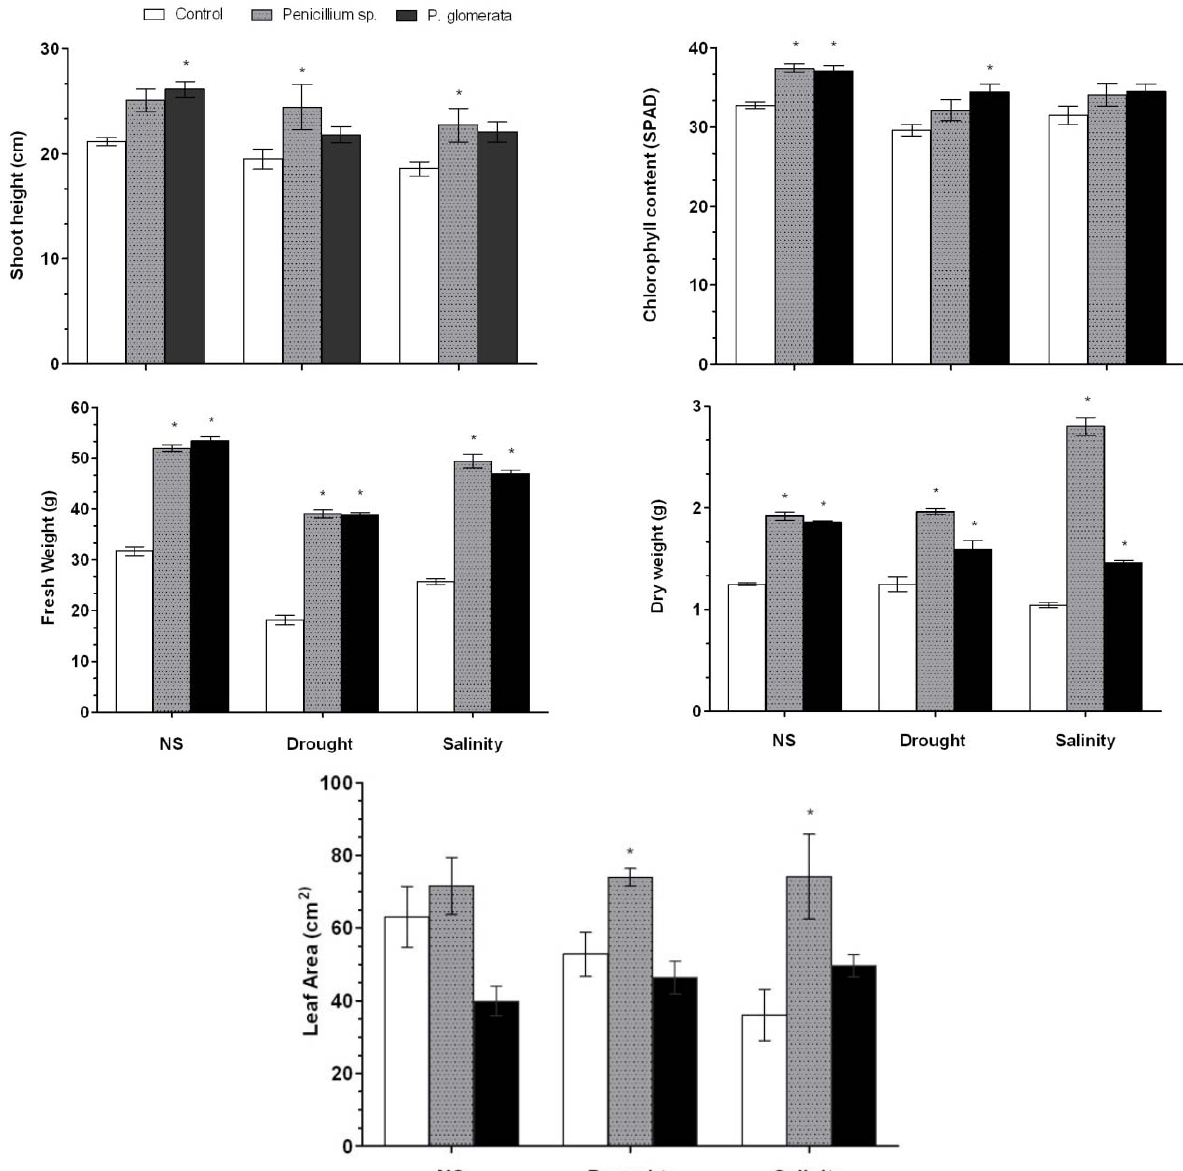
Figure 2. Growth attributes of the cucumber plants infested with the two endophytes, i.e ., Penicillium sp. and P. glomerata with or without salinity and drought stress conditions. The growth parameters include, shoot height, shoot fresh weight, dry weight, chlorophyll content and leaf area. ( n = 18). Each value is the mean ± SD of three replicates per treatment. NS stands for no-stress treatments. The ‘*’ indicates that values are significantly different from control ( p <